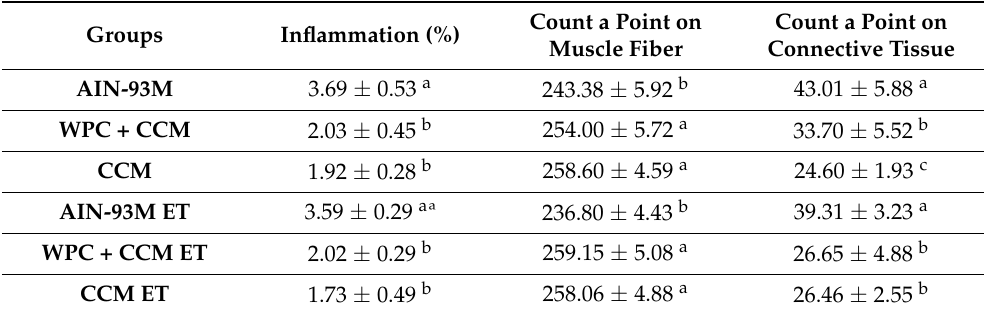
Table 4. Histopathology of the muscle of rats that were submitted or not to an exhaustive swimming